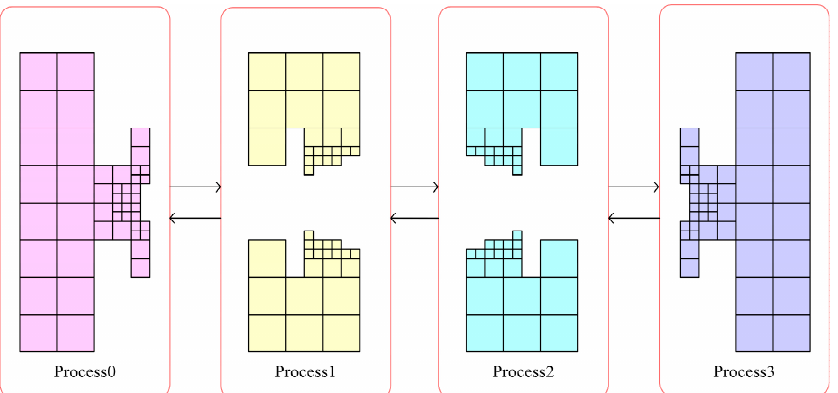
Figure 13. Multi-layer grid LBM parallel strategy and data-transfer method.